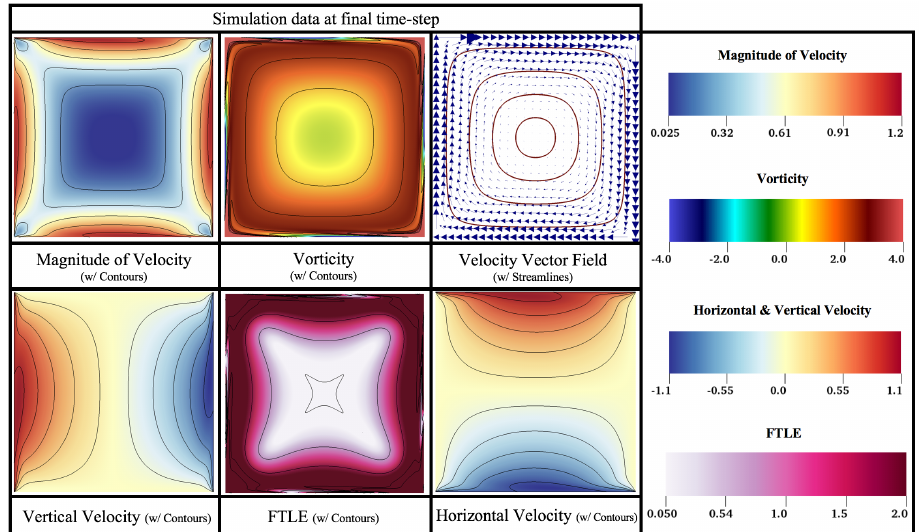
Figure 24. Illustration of some of the data produced for the circular flow example, using the projection method. The data shown is from the final time-step for Re =